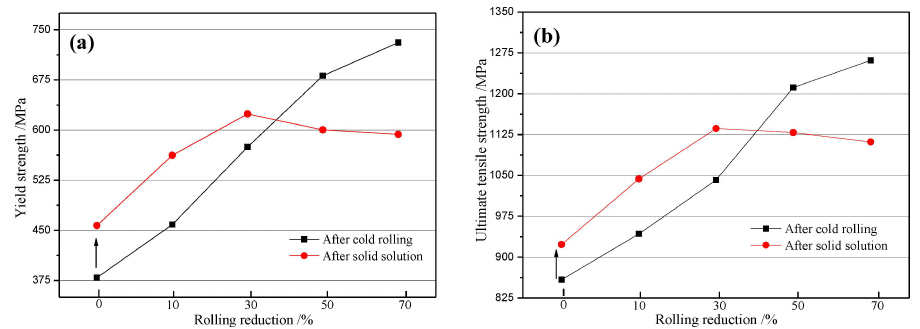
Figure 4. Mechanical properties after cold rolling and solid solution ( a ) Yield strength ( b ) Ultimate tensile strength.